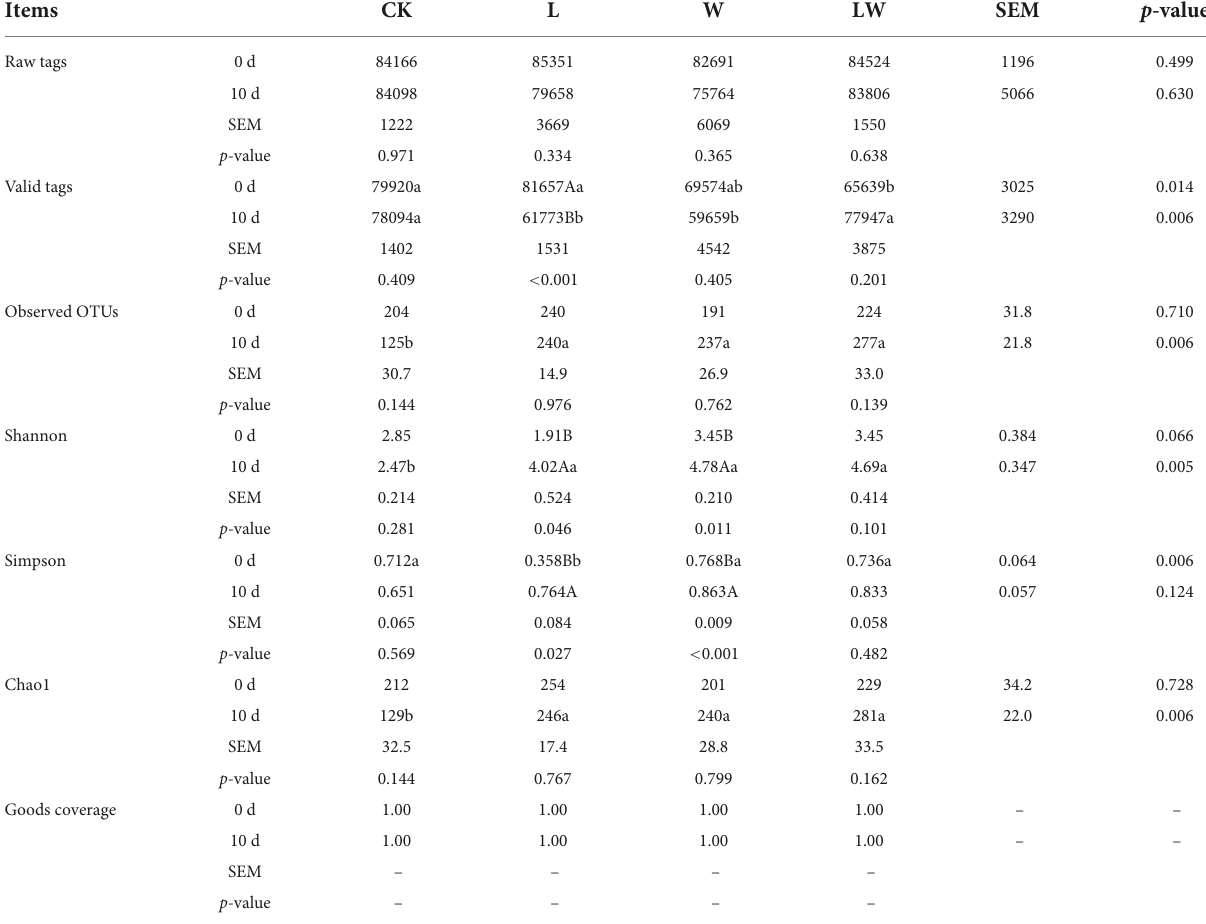
TABLE 4 Sequencing data and alpha diversity of bacteria in Leymus chinensis silages ( n =